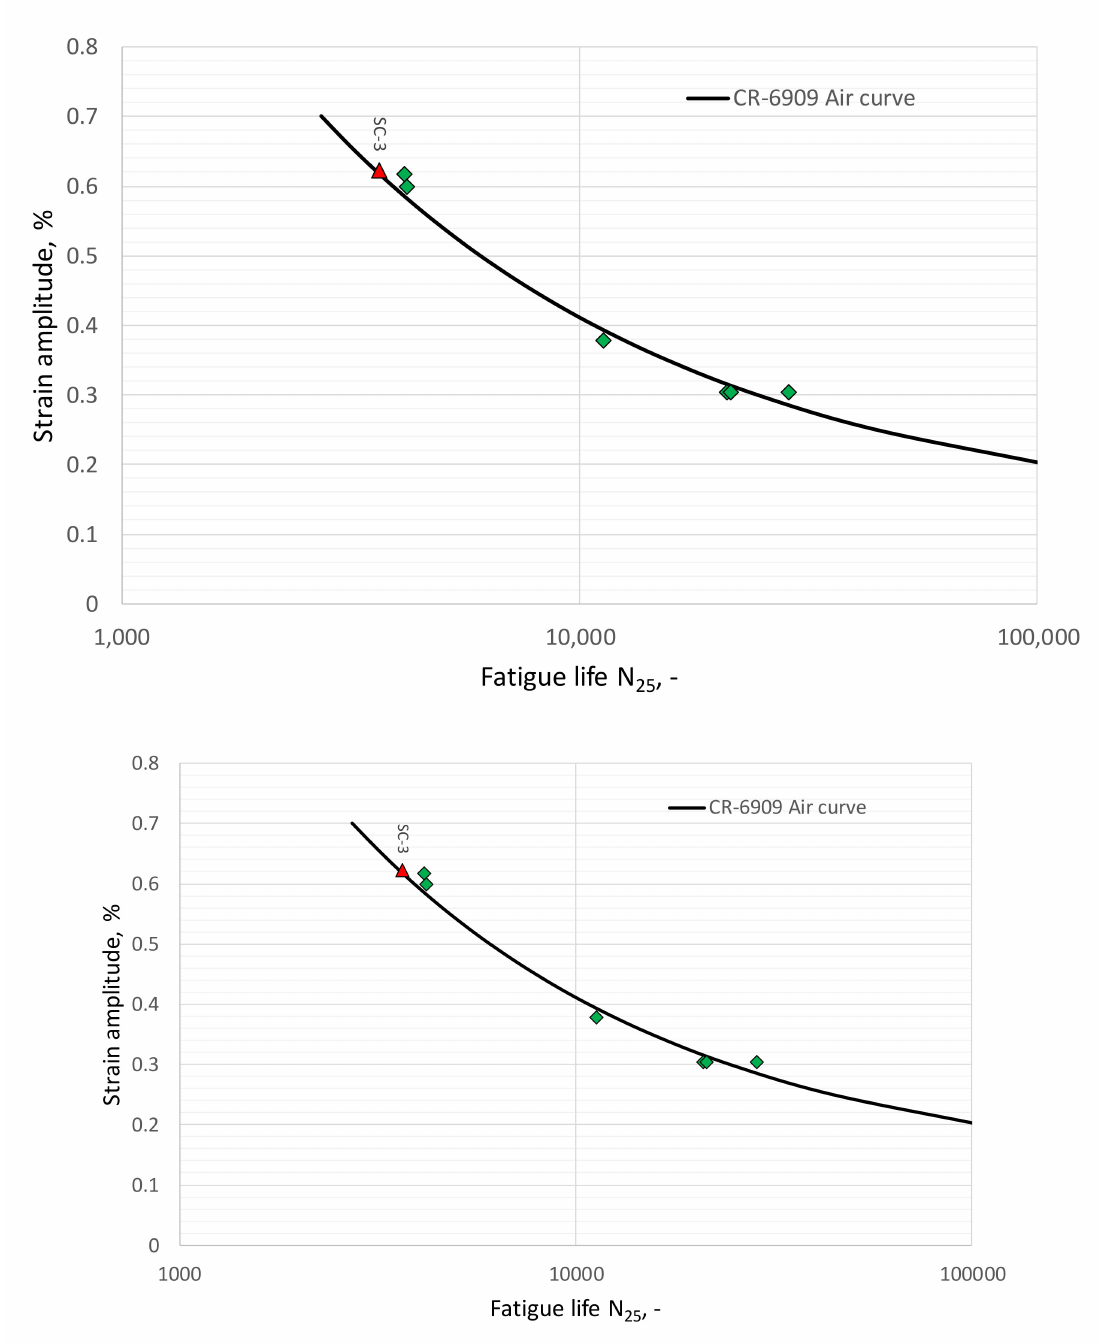
Figure 4. Air fatigue life results and NUREG / CR6909 mean air